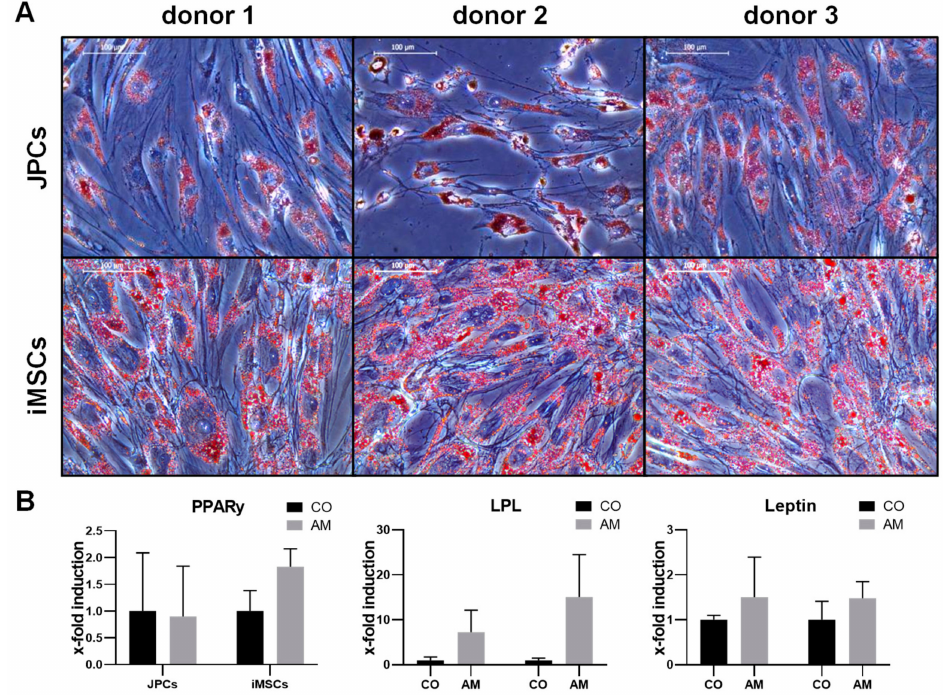
Figure 1. Adipogenic di ff erentiation of jaw periosteal cells (JPCs) and iPSC-derived mesenchymal stem / stromal-like cells (iMSCs). ( A ) Microscopic images (20 × magnification, scale bar = 100 µ m) of oil red stained JPCs (upper panel) and iMSCs (lower panel) after 15 days (donor 3 JPCs only 10 days) of adipogenic di ff erentiation. ( B ) Expression levels of adipogenic marker genes ( PPAR γ , LPL, and leptin ) of JPCs and iMSCs cultivated for 10 days in adipogenic medium (AM) were normalized to levels of the housekeeping gene GAPDH and presented as x-fold induction relative to those of respective cells cultivated in control medium (CO). Di ff erences in gene expression were compared using two-way ANOVA ( n =